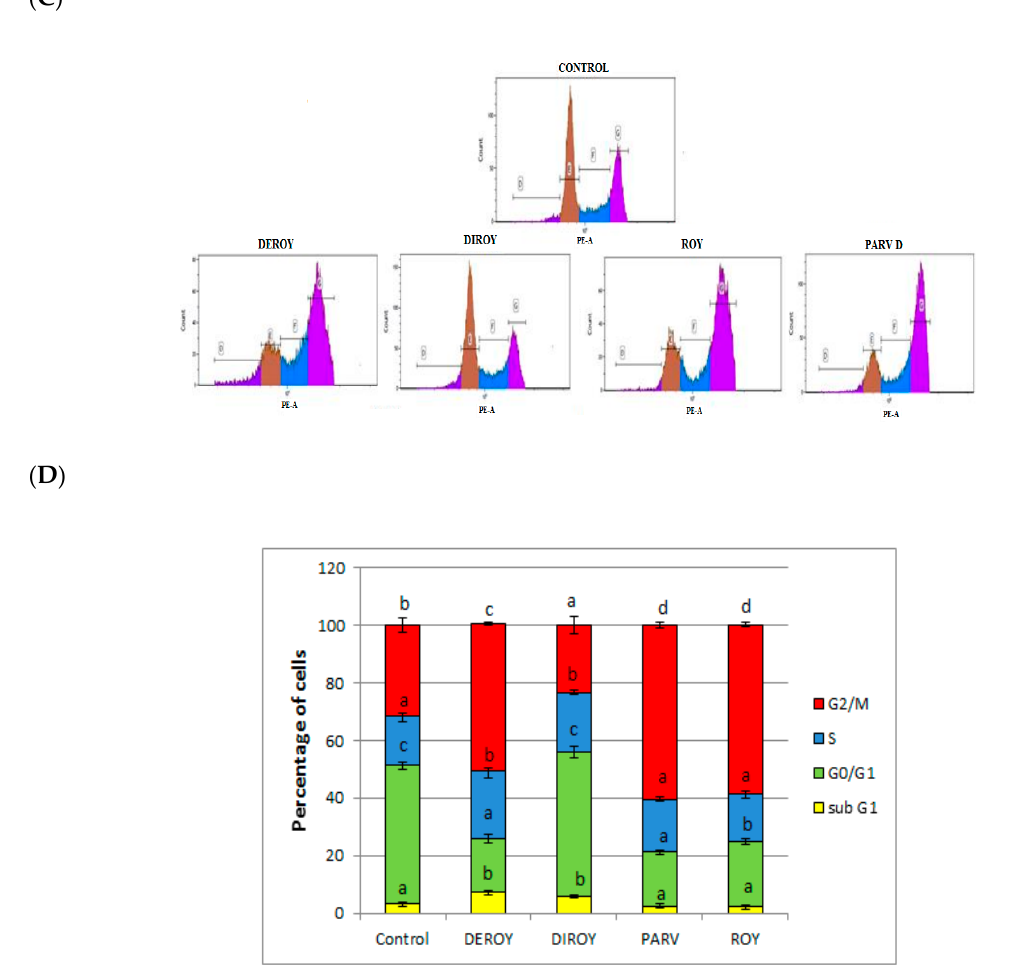
Figure 3. ( A ) Representative histograms of apoptosis/necrosis analysis of primary H7PX glioma cells after 24-h treatment with abietane diterpenes ( B ) The percentage of primary H7PX glioma cells in early and late apoptosis after 24-h treatment. ( C ) Representative histograms of primary H7PX glioma cell cycle distribution after 24-h treatment ( D ) The percentages of individual cell cycle phases after 24-h treatment. The values represent mean ± SD of three independent experiments. Different letter indicates differences at the P<0.05. In all figures, Deroy (6,7-dehydroroyleanone), Diroy (7 β ,6 β -dihydroxyroyleanone), Roy ( 7 α -acetoxy-6 β -hydroxyroyleanone) and Parv D (parvifloron D).